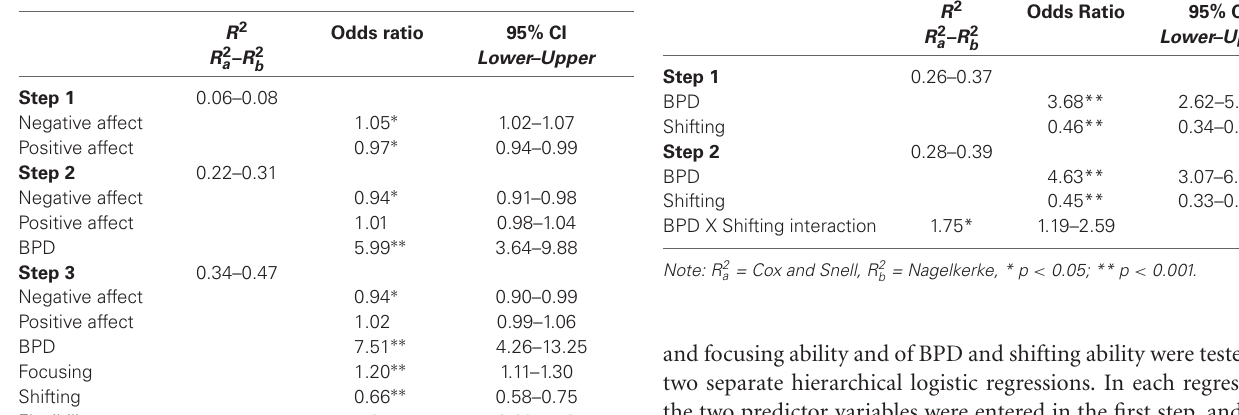
Table 3 | Hierarchical Logistic Regression testing main effects of affect; attentional control; and BPD features on prior incidence of self-harm .